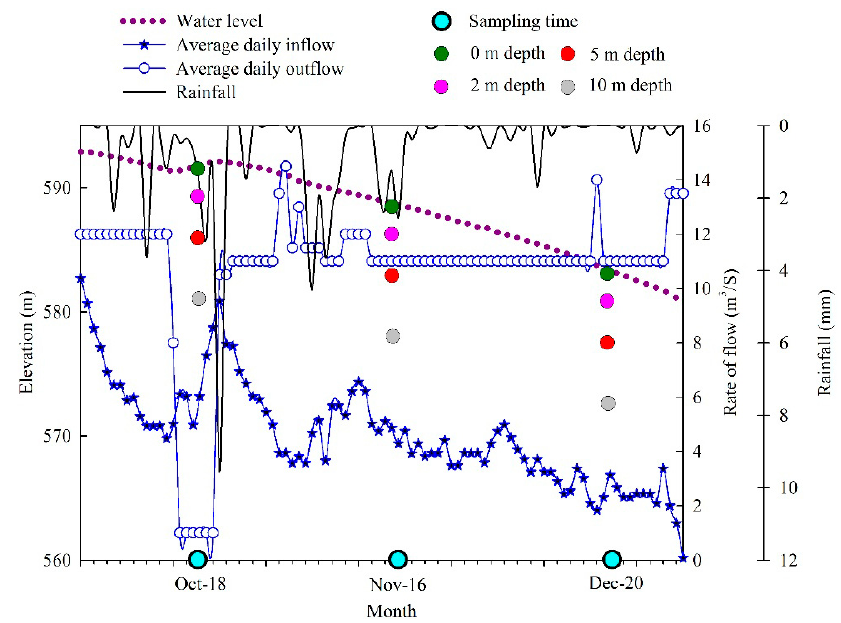
Figure 1. Water level, average daily inflow and outflow, rainfall, sampling times and depth in Jinpen reservoir from October to December 2018.